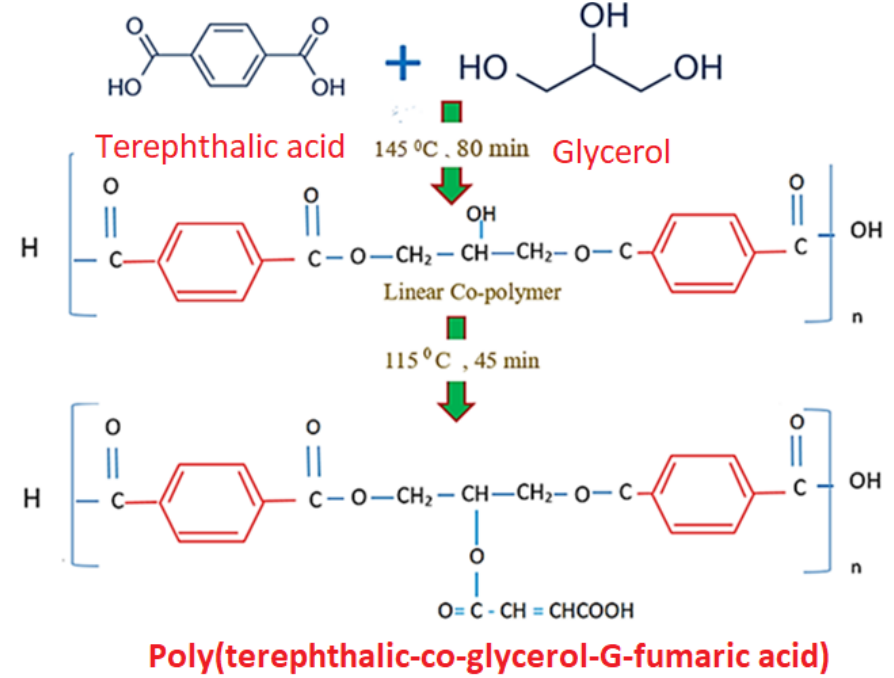
Figure 1. Reaction of terephthalic acid and glycerol for TGF graft polymer